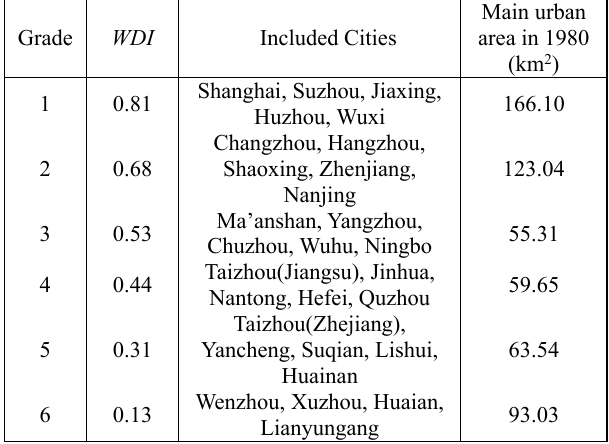
Table 1. Classification result according to weighted distance